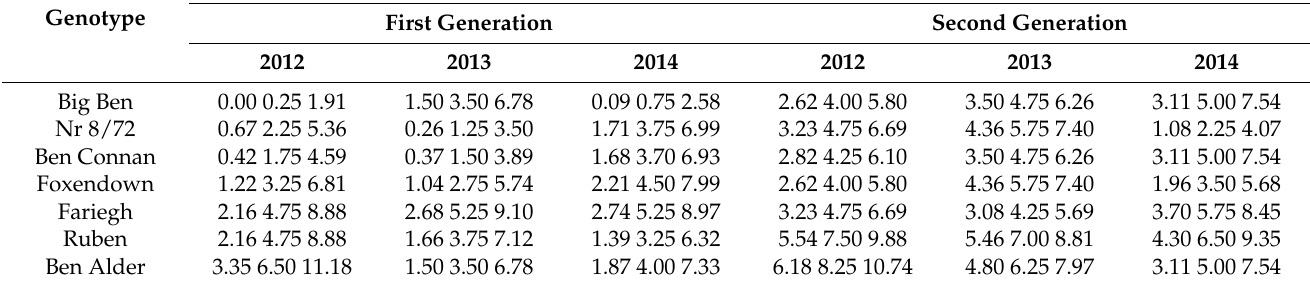
Table 4. Estimated mean number of larvae from four five-shoot replications per genotype. The cells show estimates with 95% confidence intervals estimated using generalized linear models. The genotypes sorted are according to the increasing mean probability across the three years and both pest